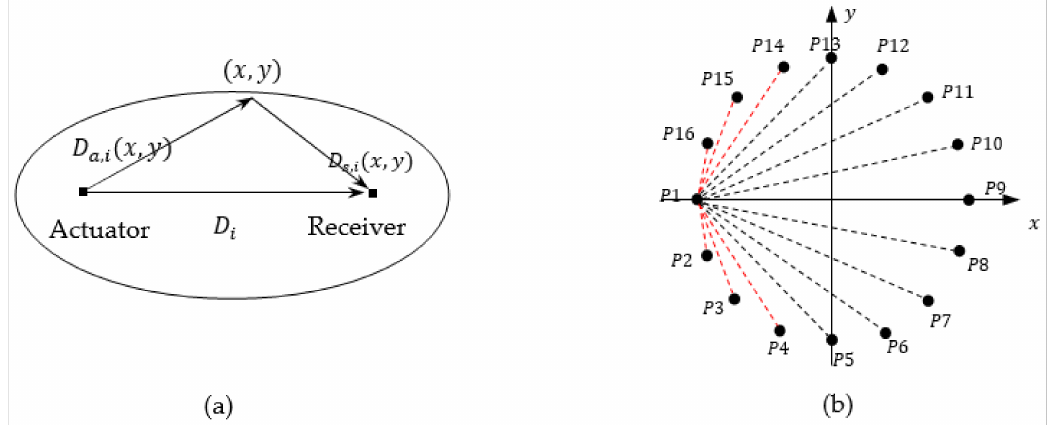
Figure 1. Schematic diagram of RDI and path selection: ( a ) Schematic diagram of RD i ; ( b ) Schematic diagram of the path